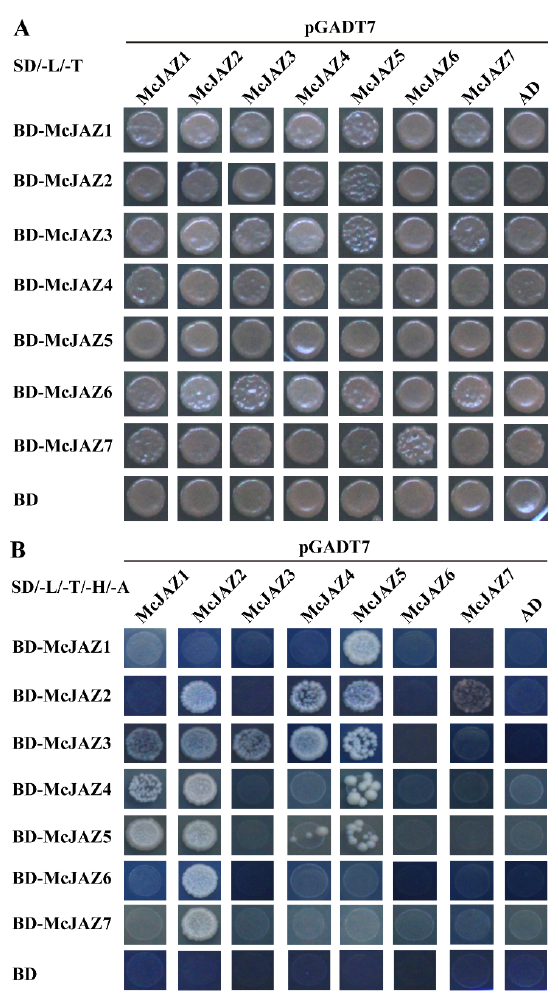
McJAZ3, and McJAZ5 could form homodimers by reciprocal interaction in yeast. Mean- while, the different heterodimeric interactions were also observed among the seven McJAZ proteins (Figure 9B). For instance, the interactions between McJAZ1 and McJAZ5, McJAZ2 and McJAZ4, McJAZ5 or McJAZ7, McJAZ4 and McJAZ5 were observed in recip- rocal transformations in yeast. Furthermore, McJAZ1 only interacted with McJAZ3, McJAZ4 as the prey, and McJAZ2 interacted with McJAZ3, McJAZ6 as the prey. McJAZ3 could interact with McJAZ1, McJAZ2, McJAZ4 and McJAZ5 as the bait rather than the prey. As the bait, McJAZ6 only interacted with McJAZ2, but no interaction was detected using McJAZ6 as the prey. In addition, the rest of combinations including McJAZ7 and other McJAZ proteins failed to form heterodimers, except for a heterodimeric interaction between McJAZ7 and McJAZ2 that was observed regardless of whether McJAZ7 was used as the prey or the bait. These results suggest the existence of homo- or heterodimeric in- teractions among McJAZ proteins in M. canadensis .